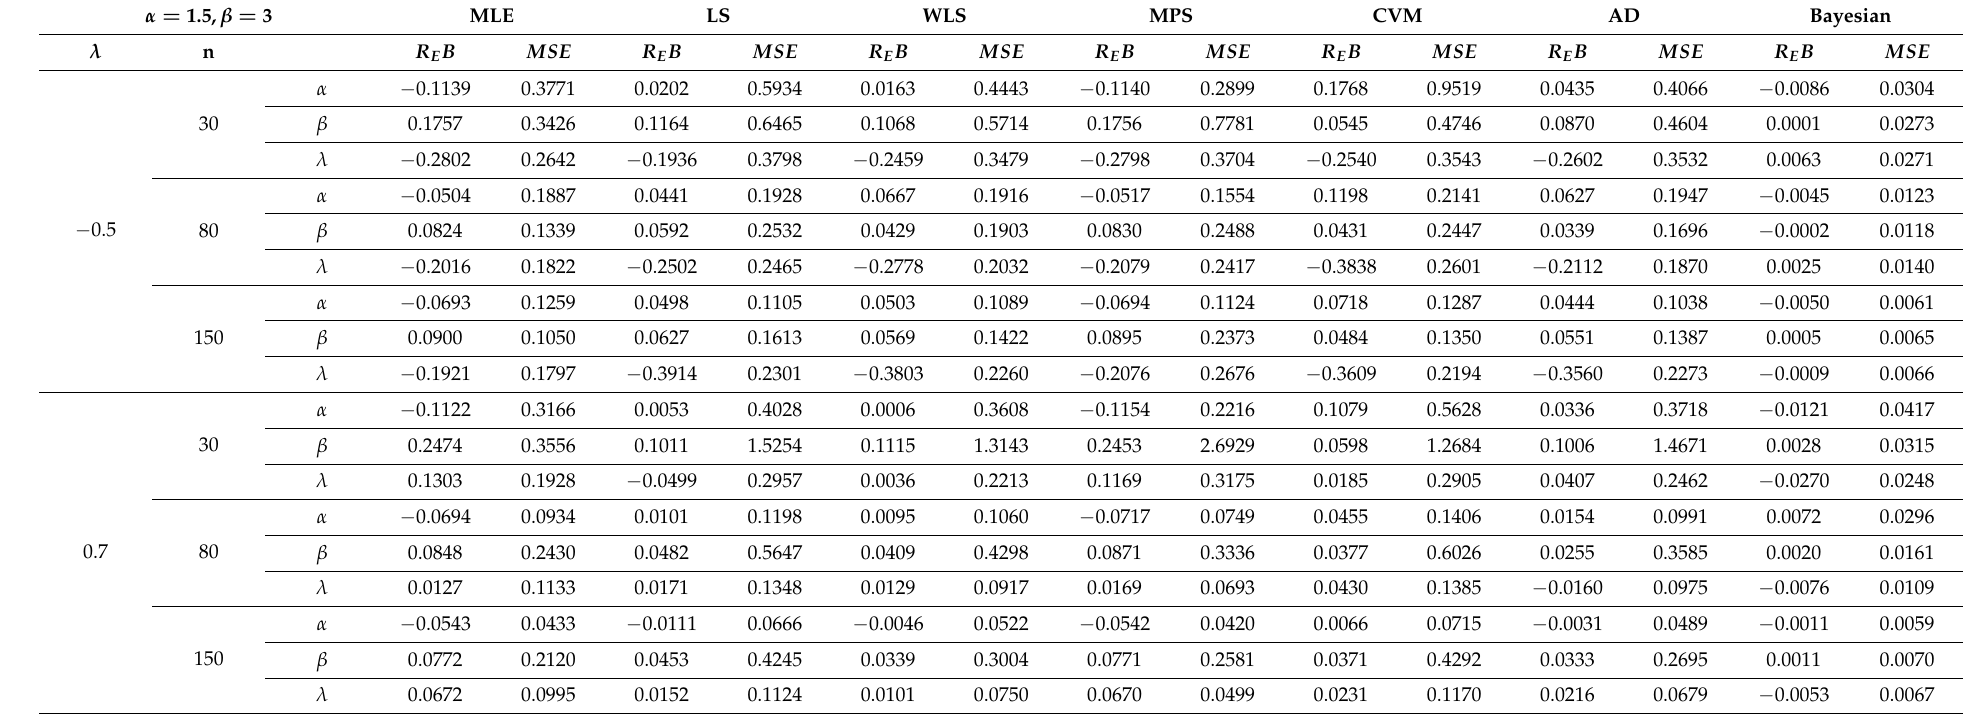
Table 6. Numerical outcomes of R E B and MSE for all estimation approaches at Case